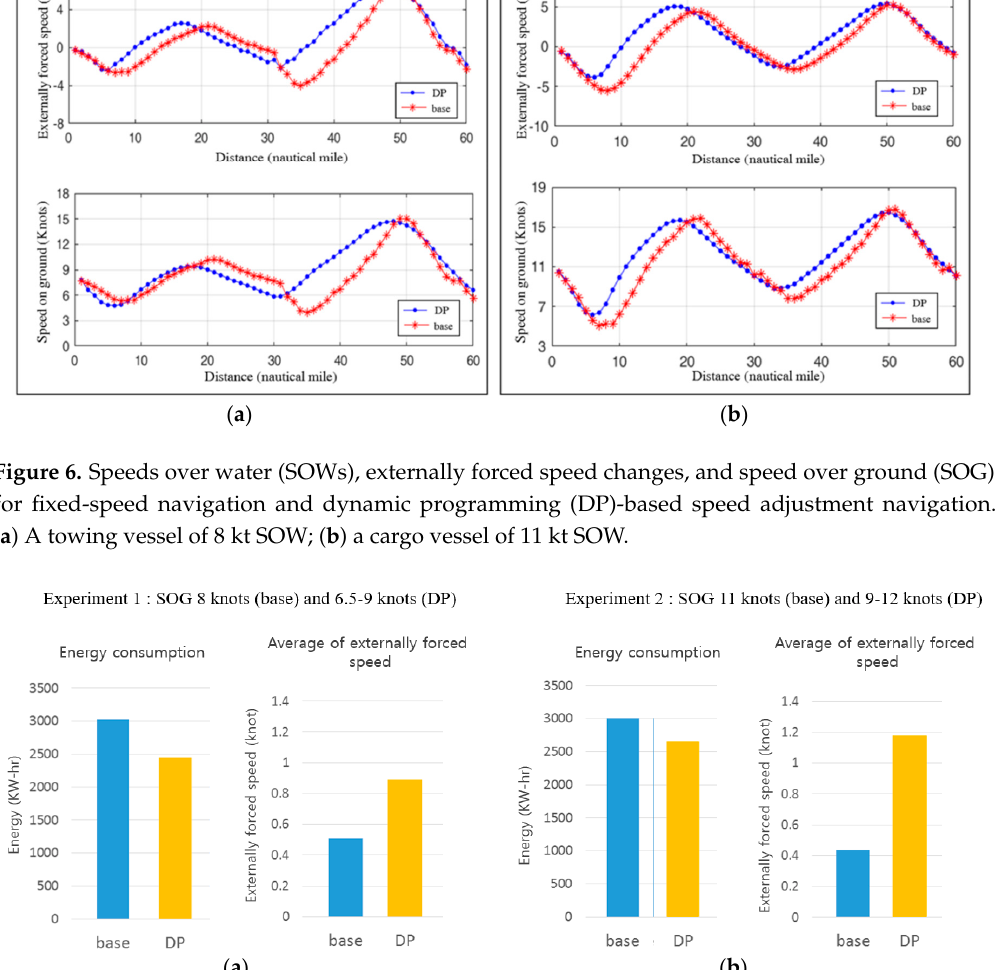
Figure 7. The energy consumption and the average of externally forced speeds for the fixed-speed navigation and the dynamic programming (DP)-based speed adjustment navigation. ( a ) A towing vessel of 8 kt speed over water (SOW); ( b ) a cargo vessel of 11 kt SOW.